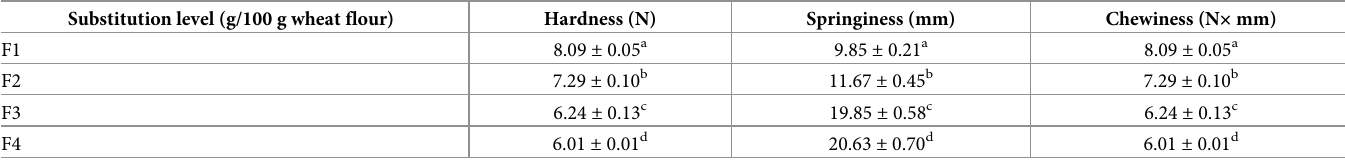
Each value in the table is represented as mean ± SD (n = 5). a,b,c,d Values with same superscript letters in the same row are non-significant at p < 0.05.